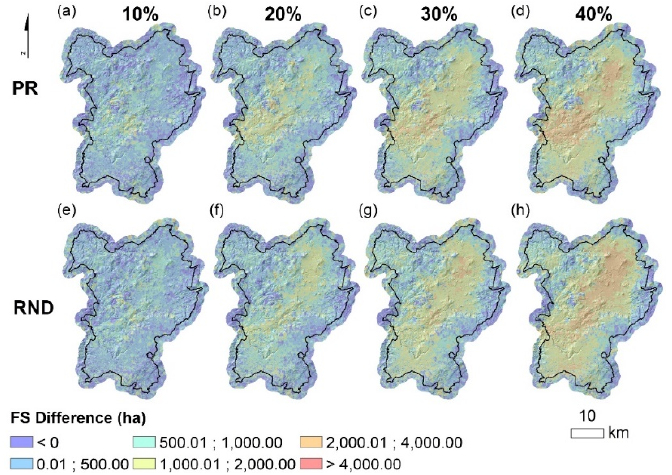
Figure 7. Fire size (FS) difference between the two spatial patterns of land abandonment scenarios (priority (PR; a – d ) and random (RND; e – h )) and the NA conditions, considering 10, 20, 30, and 40% of agropastoral land abandonment.